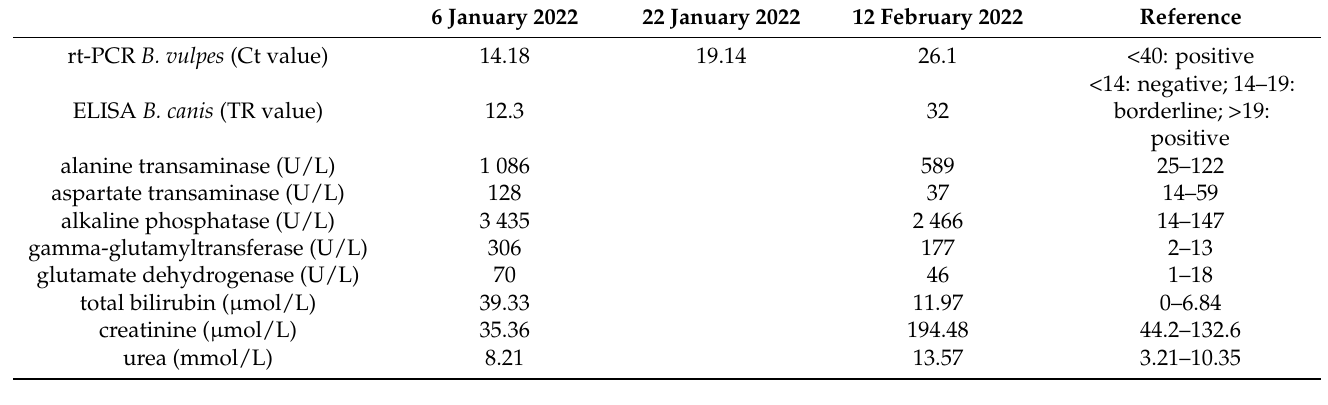
Figure 1. Erythrocyte counts ( a ), thrombocyte counts ( b ), and cell counts of leucocytes ( c ) at exam- ined time points. Each point represents the measured value of each time point, and dotted lines represent reference values. Dates in blue are time points where measurement was performed with the ProCyte One ® Haematology Analyser (IDEXX, Vienna, Austria). Table 1. Results of cycle threshold (Ct) value of B. vulpes rt-PCR, test result (TR) value of ELISA antibody test, liver enzymes, creatinine, and urea from the blood analysis of three different time points.